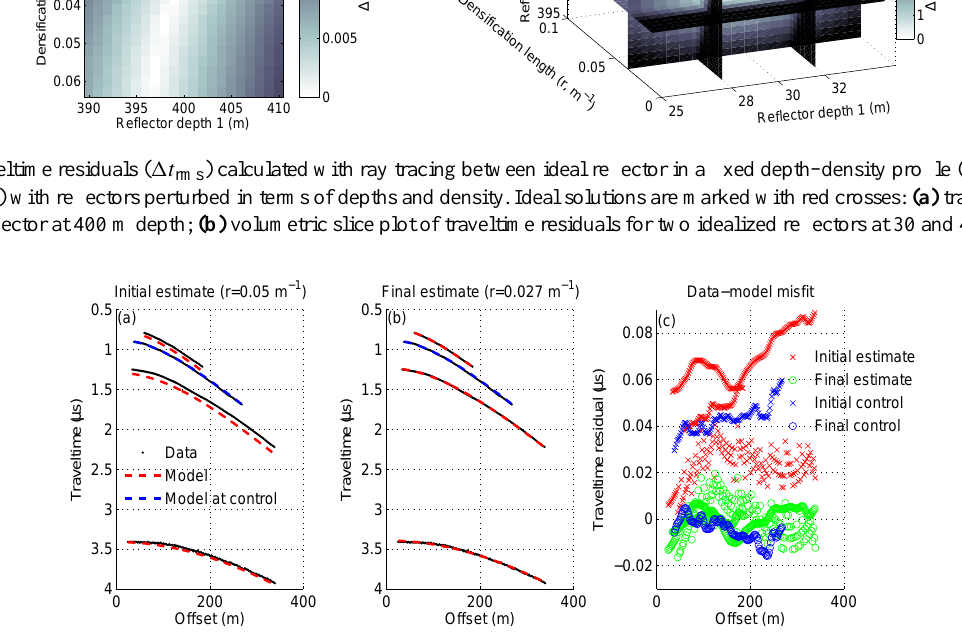
Figure 5. Example for initial (a) and final (b) fit between the ray tracing forward model and the reflectors at Site 2. In this case, three reflectors (black dots) were used for the inversion and one reflector was kept for control. The forward model corresponds to the red dashed curves and the control reflectors to the blue dashed curves. Initial estimates shown here were r 0 = 0.05m − 1 , D 1 = 68.2m, D 3 = 112.9m, D 4 = 291.2m; the best fit resulted in r = 0.027m − 1 , D 1 = 67.7m, D 3 = 111.2m, and D 4 = 293.3m. The traveltime residual between the model and data for initial (x) and final fit (o) is shown in (c)